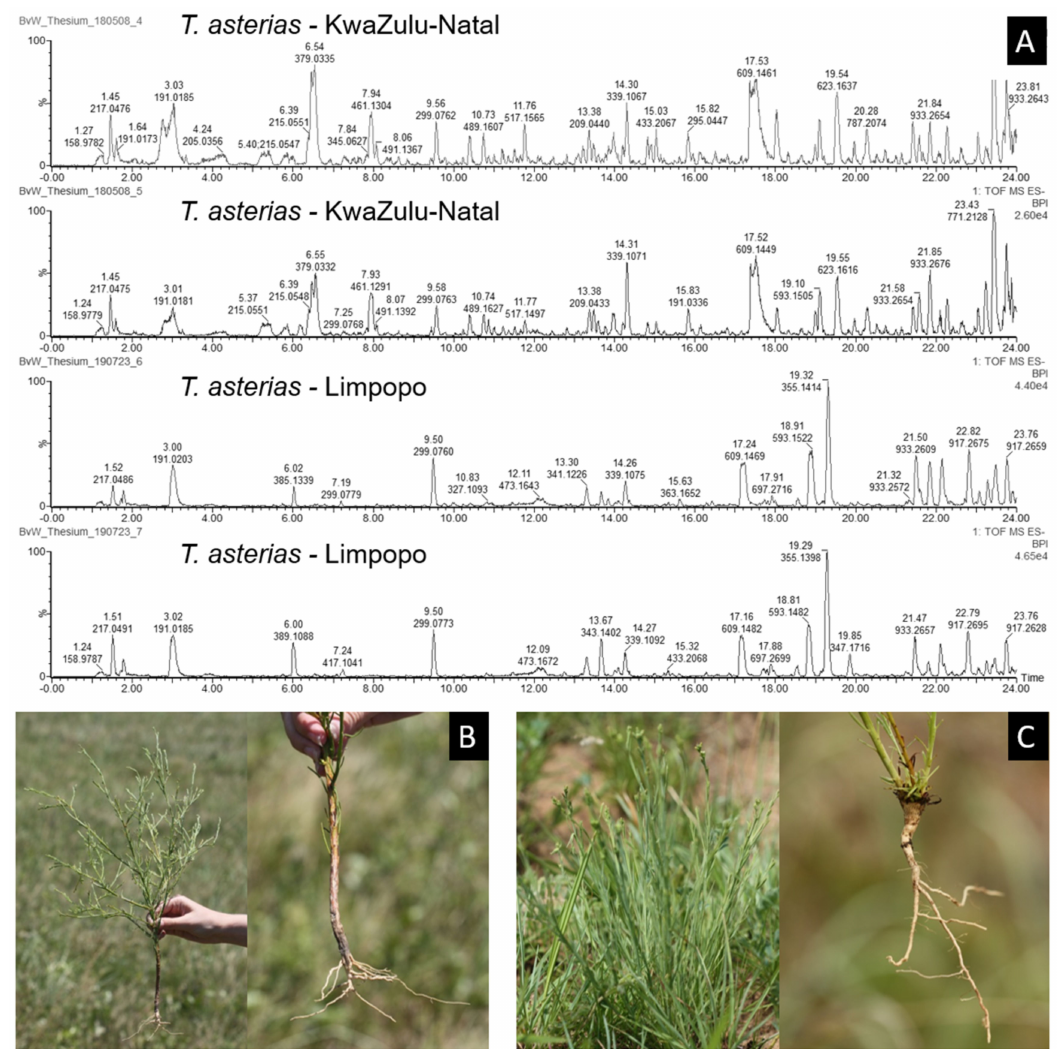
Figure 7. Differences in phenolic compound composition and morphology between two populations of Thesium asterias . ( A ). Total ion chromatograms of two T. asterias plants from a single population near St. Lucia, KwaZulu-Natal, South Africa ( top ) and two T. asterias plants from a single population near Lekgalameetse Nature Reserve, Limpopo, South Africa ( bottom ). ( B ). Habit, with branches spreading at ± 45 ◦ , and slender rootstock of T. asterias plants from KwaZulu-Natal. ( C ). Habit, with parallel and virgate branches, and thickened rootstock of T. asterias plants from